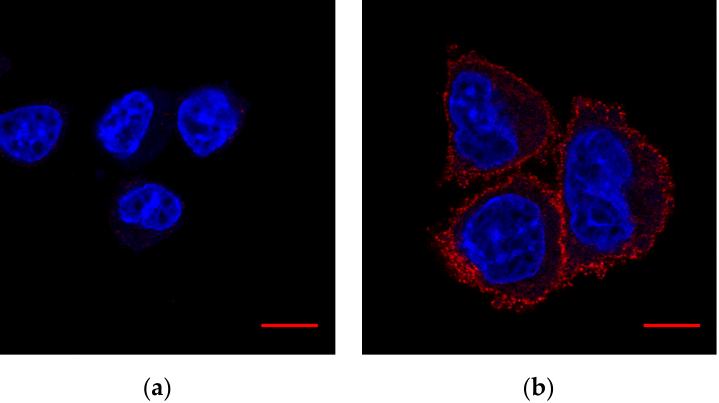
Figure 2. Validation of antibody #BAF3264. Fixed cells. Hoechst 33342 (DNA)—blue, #BAF3264 (T-cadherin)—red: ( a ) Wild-type CHO; ( b ) CHO cells with T-cadherin expression. Scale bar (red line) 10 μ m. T-cadherin was detected on the surface of platelets but not on leukocytes using immunostaining and confocal microscopy (Figure 3).